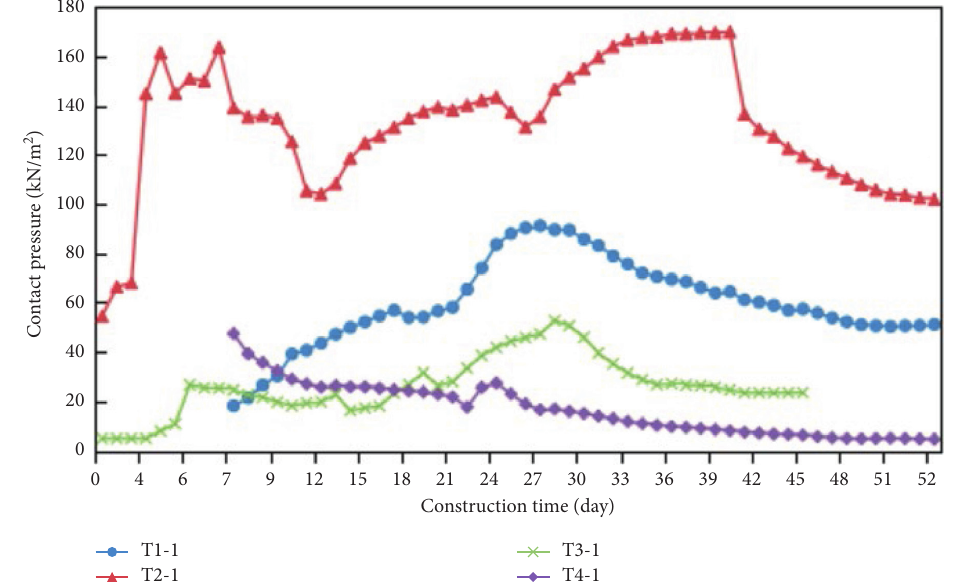
Figure 37: Contact pressures between surrounding rocks and primary